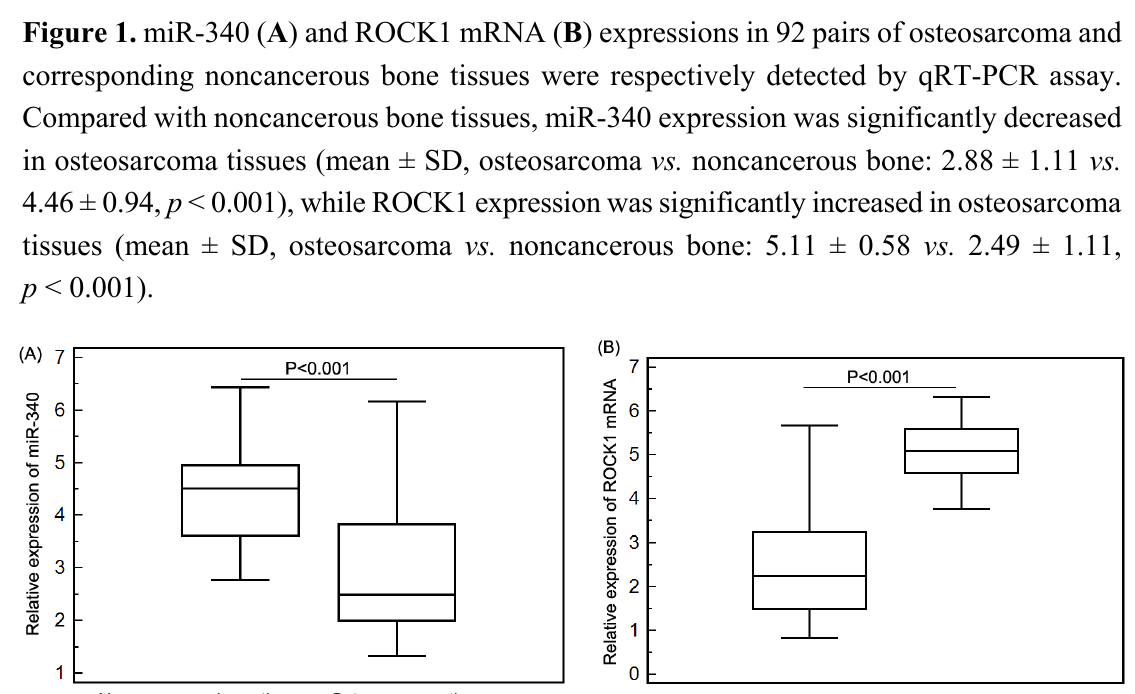
Figure 1. miR-340 ( A ) and ROCK1 mRNA ( B ) expressions in 92 pairs of osteosarcoma and corresponding noncancerous bone tissues were respectively detected by qRT-PCR assay.